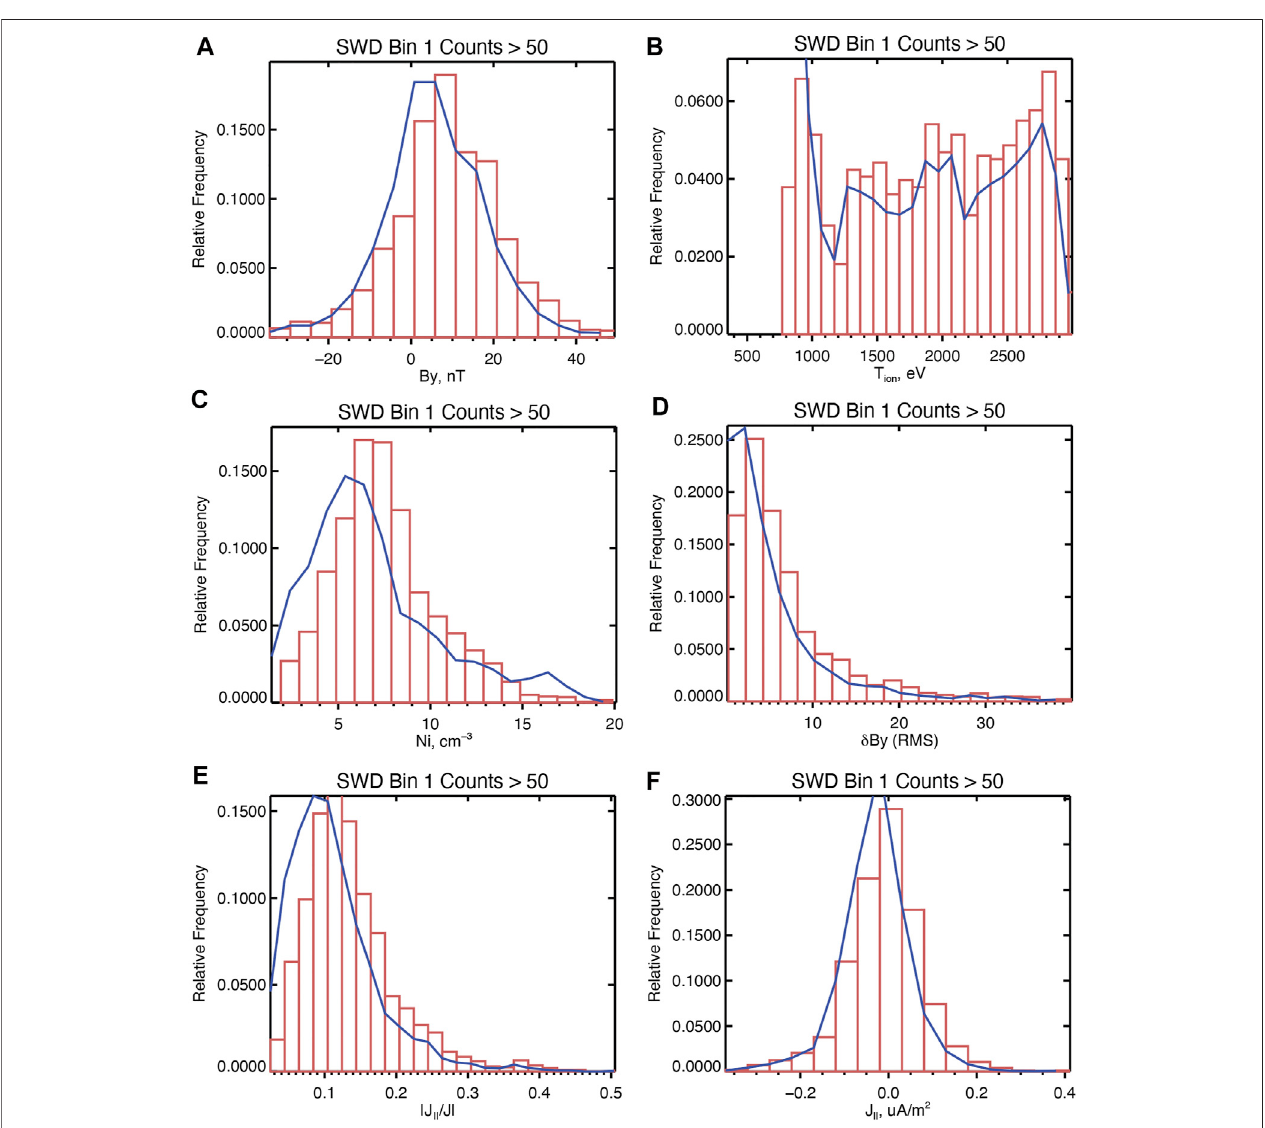
FIGURE11| Histogramsofmagnetic fi eldandplasmaquantitiesduringtheSeptember27,2016burstinterval,giveninthesameformatas Figure4 . (A) Magnetic fi eld GSE B Y , (B) Ion temperature, T ion , (C) Ion number density, N i , (D)